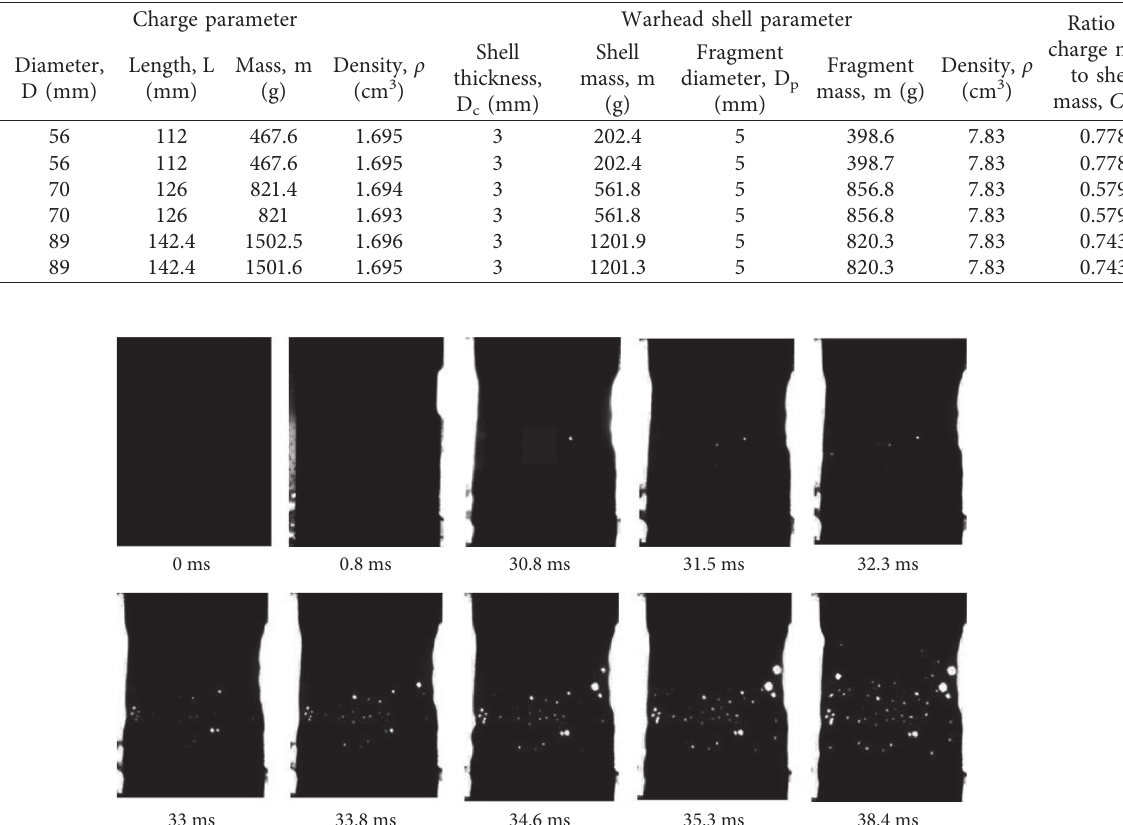
Table 1: Parameter specifications of cylindrical-warhead samples with charge and fragments.